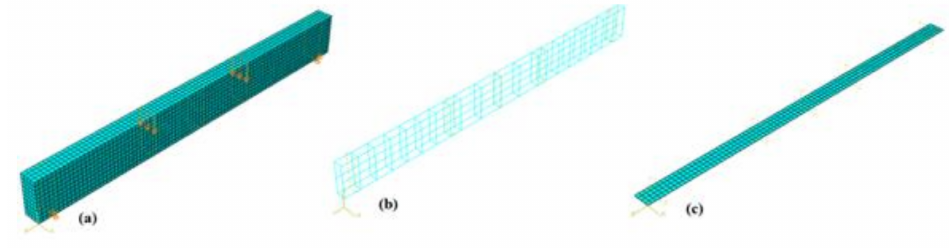
Figure 4. Numerical model of beams: ( a ) Deformable solid beam, ( b ) truss element-reinforced steel, and ( c ) shell element